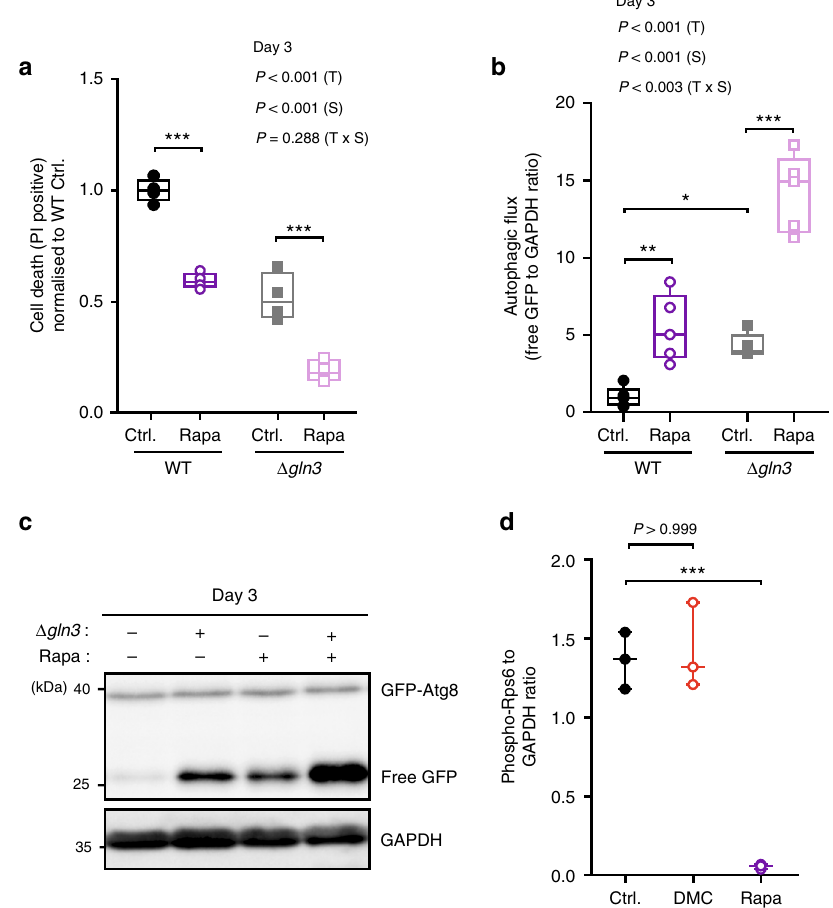
Fig. 6 Rapamycin and 4,4 ′ -dimethoxychalcone follow independent routes of cytoprotection. a – c Cell death assessed by PI staining and fl ow cytometry normalised to WT Ctrl. ( a ) and autophagy induction indicated by the free GFP to GAPDH ratio normalised to WT Ctrl. b , c of S. cerevisiae wildtype and GLN3 -de fi cient mutant strains after treatment with 40 nM rapamycin (Rapa) at day 3 of chronological ageing. Comparisons in ( a , b ) by two-way ANOVA (T, treatment; S, strain; TxS, interaction) followed by Bonferroni-corrected simple main effects. * P < 0.0483, ** P < 0.0055, *** P < 0.001, n = 4 ( a ), 5 ( b ) independent biological replicates. ( d ) Rps6 S232/S233 phosphorylation of S. cerevisiae wild-type cells after 6 h of DMC (100 µ M) or 40 nM rapamycin (Rapa) treatment as determined by immunoblotting. Comparisons by ANOVA/Bonferroni. *** P < 0.001, n = 3 independent biological replicates. Box plots represent IQR (line at median) and whiskers 10 – 90 percentile. Source data for ( a , b , d ) are provided as a Source Data fi